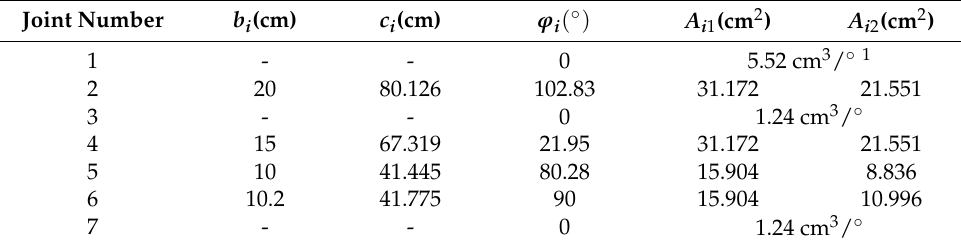
Table 2. The relevant parameters of each joint driving mechanism of the manipulator. Joint Number